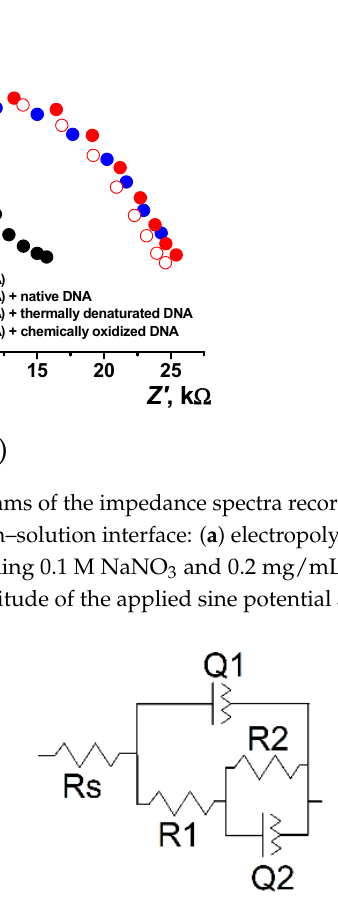
Table 1. EIS parameters obtained for poly(Azure A)–DNA assembling in various conditions of DNA treatment (average ± S.D. for six electrodes).